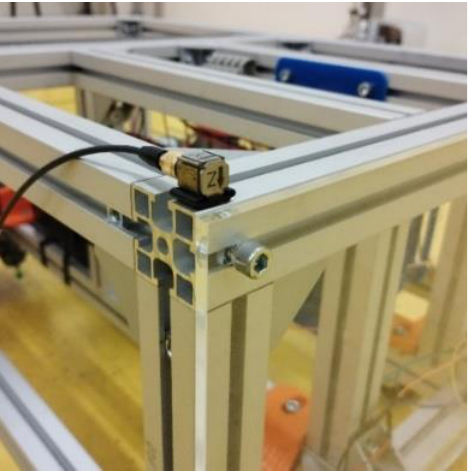
Figure 14. Position of the sensor in the upper right corner of the frame — photo.